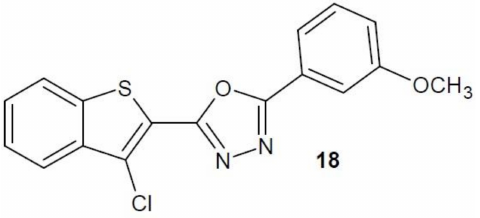
Figure 9. 1,3,4-Oxadiazole derivative with activity of nuclear factor κ B inhibitor.